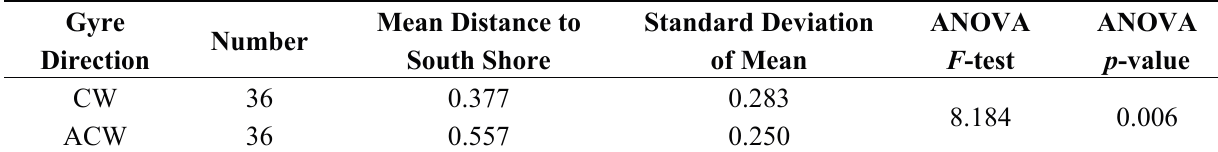
Table 7. Statistics of the locational difference of clockwise (CW) and anti-clockwise (ACW) gyres within lakes in Barrow study area.